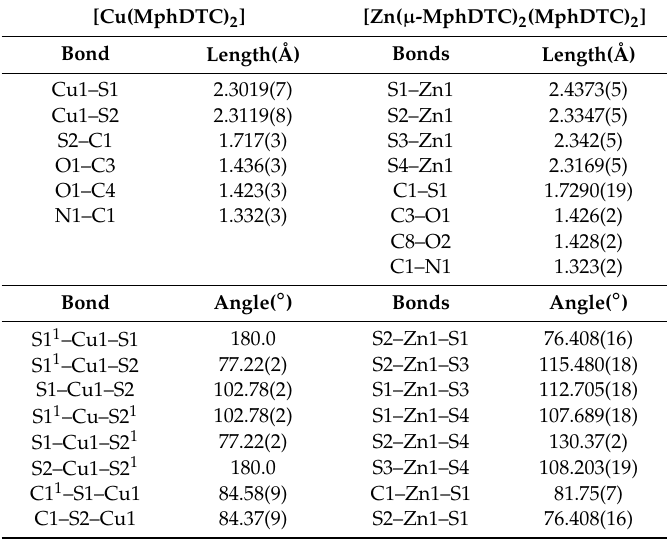
Table 2. Some selected bond lengths for the